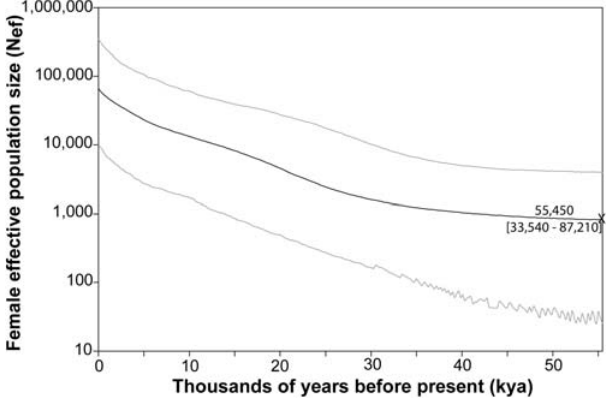
Figure 2. Bayesian skyline plot for the mtDNA HVR I + II datasets. This plot follows the conventions of Figure 1. Its estimates of coalescent time and N ef at the coalescence and today are in agreement with the coding mtDNA skyline plot (Figure 1). In contrast, this HVRI + II plot provides little resolution for other population size changes, most likely because of mutational saturation in the non- coding control region (see text).